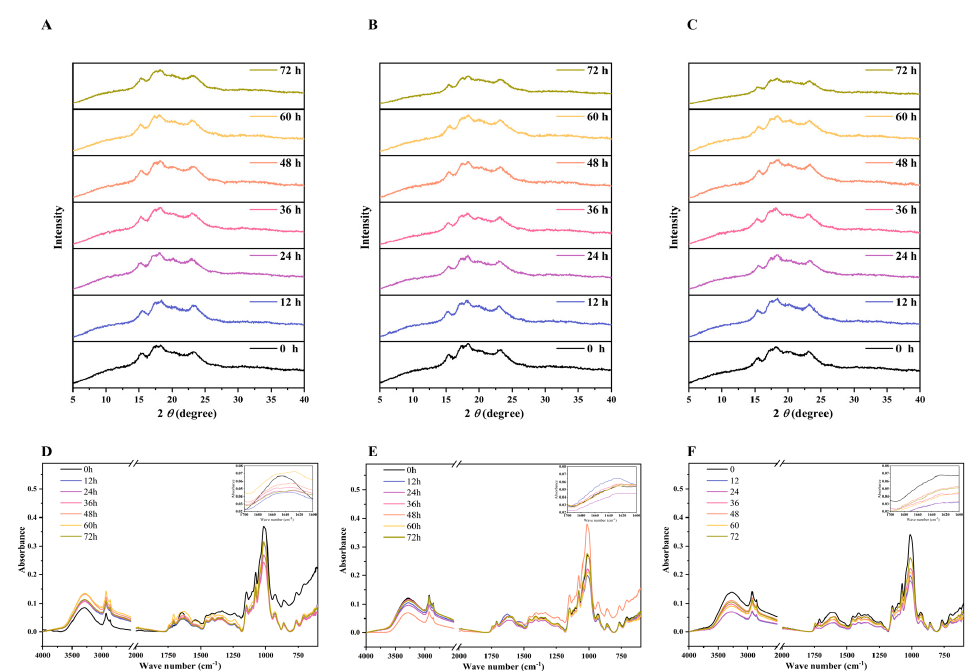
Figure 5. X-ray diffraction pattern ( A , B , C ) and FTIR absorbance spectrum ( D , E , F ) of native and fer- mented quinoa flour under cold stress at 4 °C and − 20 °C. FTIR: Fourier transform infrared spec- troscopy; Native: native quinoa flour; CQ − 4: quinoa flour cold stress treated at 4 °C; CQ − 20: quinoa flour cold stress treated at − 20 °C.